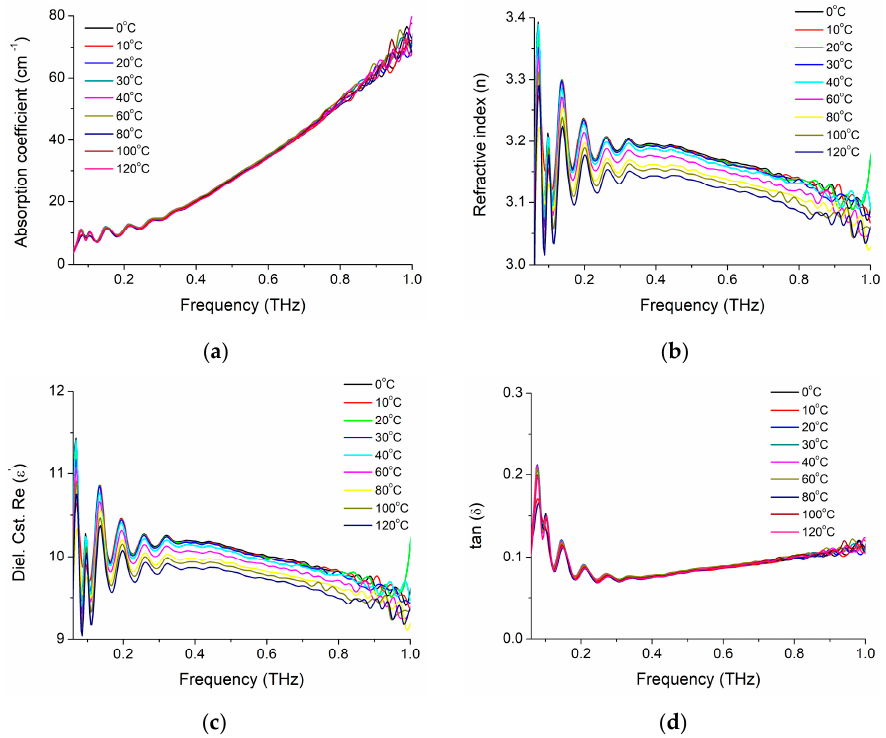
Figure 1. BaTiO 3 nanoparticle frequency dependent ( a ) absorbance, ( b ) refractive index, ( c ) dielectric constant ε′ , and ( d ) losses tangent ( tan δ ) at temperatures between 0 °C and 120 °C.